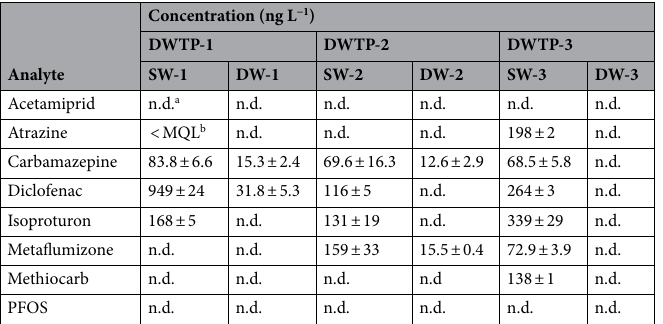
Table 2. Concentrations (ng L −1 ) of target micropollutants found in SW and DW near to the DWTP 1, 2 and 3. n.d. not detected, MQL method quantification